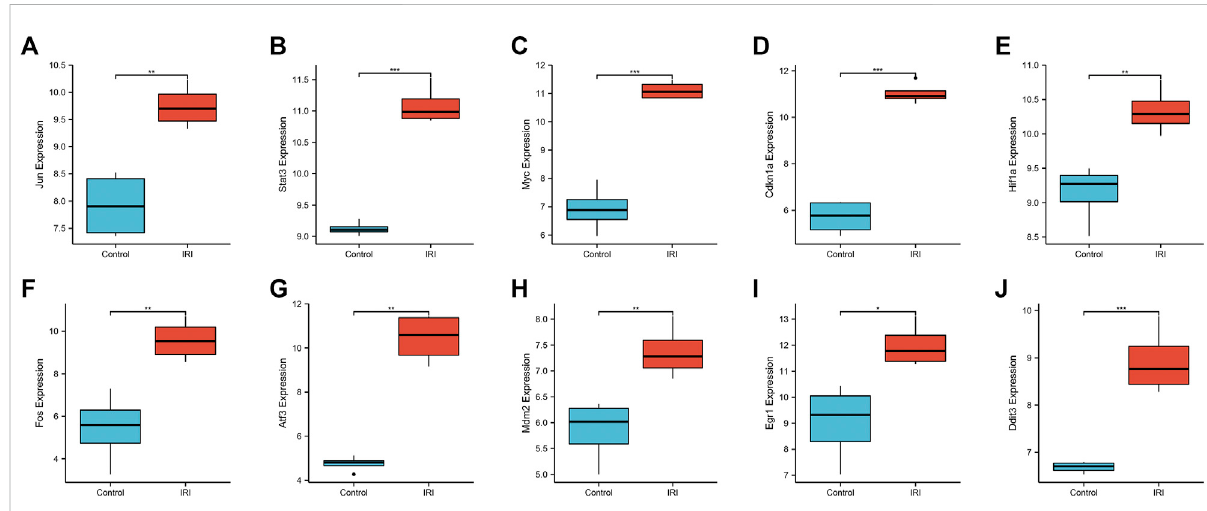
FIGURE 10 Expression levels of 10 hub genes in the GSE39548 dataset. Jun (A) , Stat3 (B) , Myc (C) , Cdkn1a (D) , Hif1a (E) , Fos (F) , Atf3 (G) , Mdm2 (H) , Egr1 (I) , and Ddit3 (J) . Differential expressionanalysis in theIRI-AKI group vs. control group inthe GSE39548 dataset. Note:*, p < 0.05; **, p < 0.01; ***, p < 0.001.